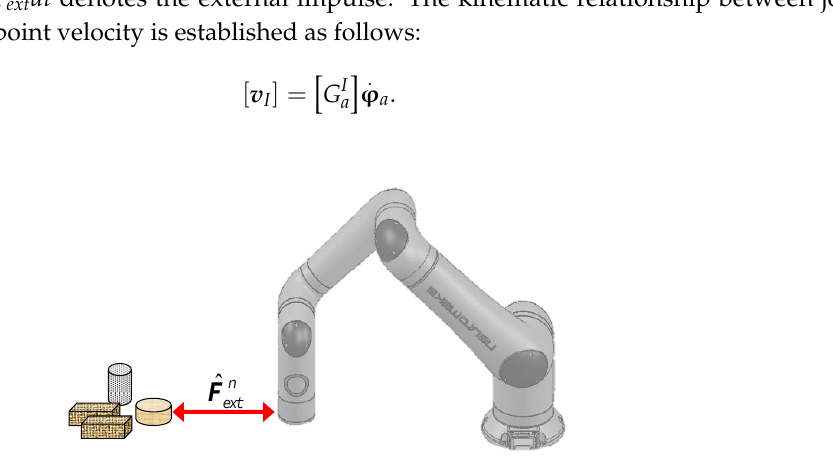
Figure 3. The scattering environmental model of robot and objects.